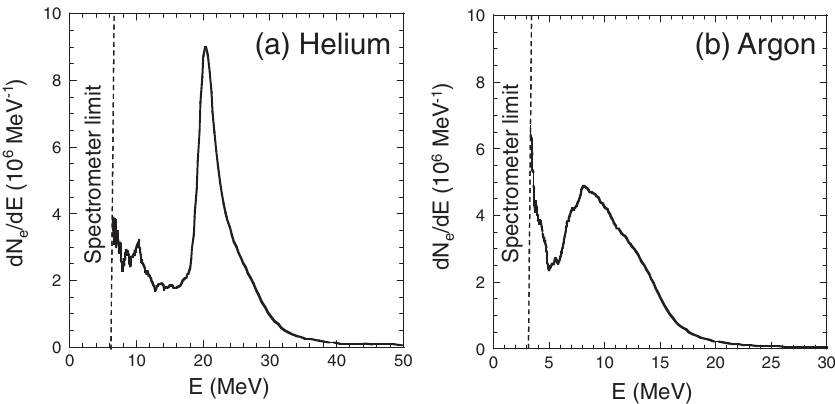
FIG. 4. Typical electron energy distributions measured in the experiment for shots with a neutral gas density of 2 : 2 (cid:3) 10 19 cm (cid:4) 3 in He and 5 : 0 (cid:3) 10 18 cm (cid:4) 3 in Ar.